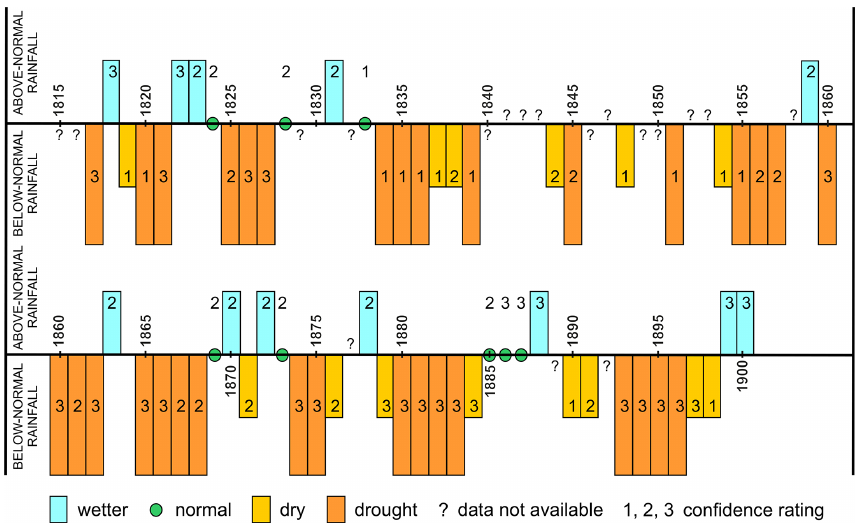
Figure 13. Five-point index of rainfall variability in Namaqualand (South Africa) during the 1800s, including the first use of confidence ratings in relation to annual classifications in a documentary-derived index series (1 denotes low confidence and 3 denotes high confidence). Data from Kelso and Vogel (2007). Table 5. Types of historical environmental phenomena reconstructed using an index approach in different parts of the world, with a qualitative indication of the relative emphasis of studies in each region (3 indicates a large number of studies, 1 a small number of studies, and “–” indicates no studies). Region Temperature Precipitation Floods Drought Snow/ice Wind/storms Europe 3 3 3 2 1 1 Africa 1